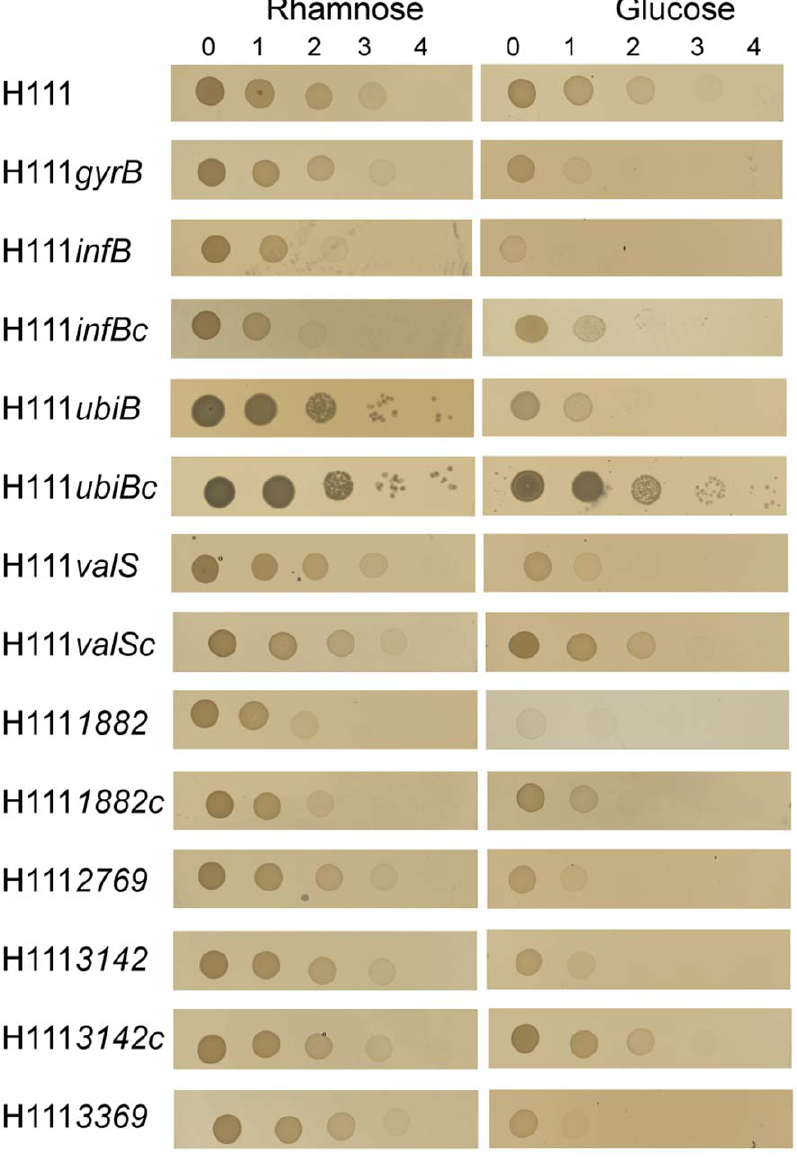
Figure 2. Conditional lethal phenotype of the rhamnose-dependent mutants of the B.cenocepacia essential genes. The constructed rhamnose-inducible mutants H111 infB , H111 gyrB , H111 uniB , H111 valS , H111 BCAL1882 , H111 BCAL2769 , H111 BCAL3142 and H111 BCAL3369 grew on LB plates supplemented with rhamnose but not with glucose as expected for mutants with essential genes under the control of rhamnose promoter. Complementation of mutants H111 infB c, H111 ubiB c, H111 valS c, H111 1882 c and H111 3142 c in trans has restored their ability to grow on glucose. Undiluted and 10-fold diluted cultures of mutants (0, 1) usually grew visibly on plates supplemented with either glucose or rhamnose prior to depletion of the existing protein; however, at 100, 1000 and 10000- fold dilutions (2, 3, 4) mutants were unable to grow on plates supplemented with glucose enough to be seen by eye.